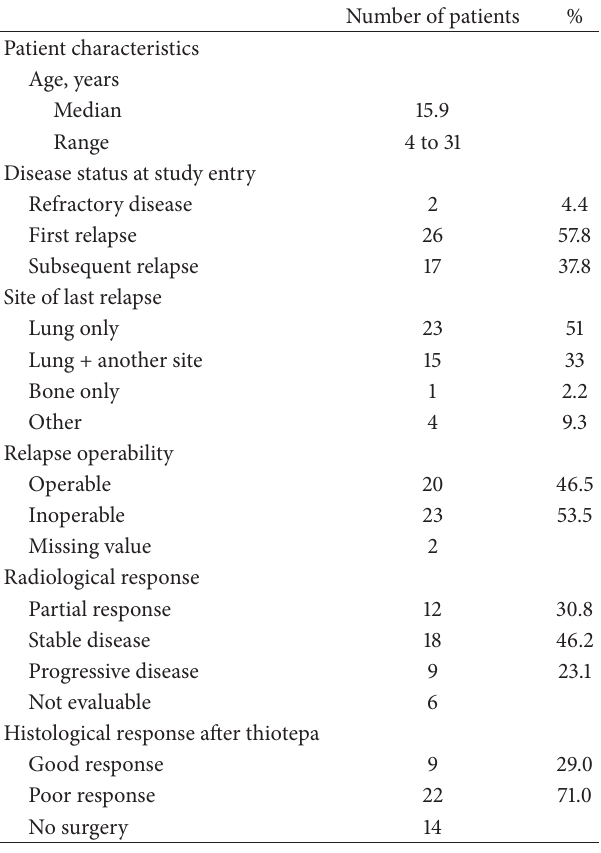
Table 1: Patient and disease characteristics at initial diagnosis ( 𝑁 = 45 ).